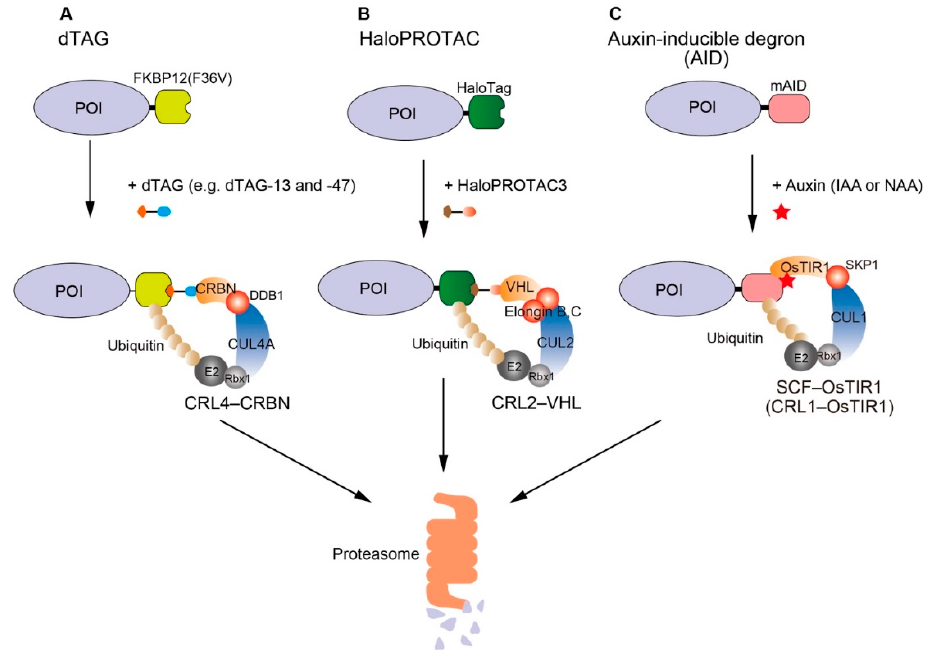
Figure 1. Schematic illustration of degron-based technologies for protein depletion in the presence of a defined ligand. ( A ) dTAG: a chemical degrader such as dTAG-13 and -47 binds a FKBP12(F36V)-fused POI and CRL4–CRBN, resulting in rapid degradation of the FKBP12(F36V)-fused POI via USP. ( B ) HaloPROTAC: a chemical degrader such as HaloPROTAC3 binds a HaloTag-fused POI, resulting in rapid degradation of the HaloPROTAC-fused POI via USP. ( C ) Auxin-inducible degron (AID): IAA or NAA binds OsTIR1, a component of SCF–OsTIR1. Subsequently, an mAID-fused POI is recognized for rapid degradation via